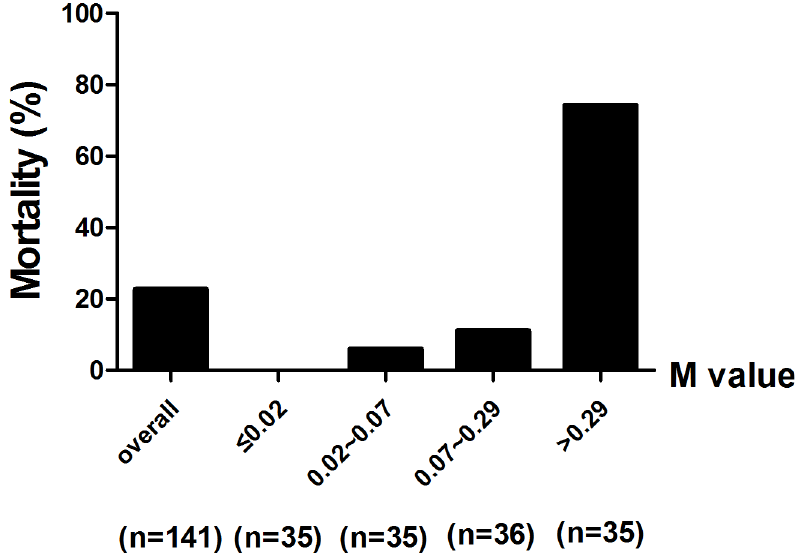
Fig 4. Mortality rate of the SFTS patients with different M value during 30 days’ follow-up. M value = the model (M) value. One patient was excludeddue to incompletedata.